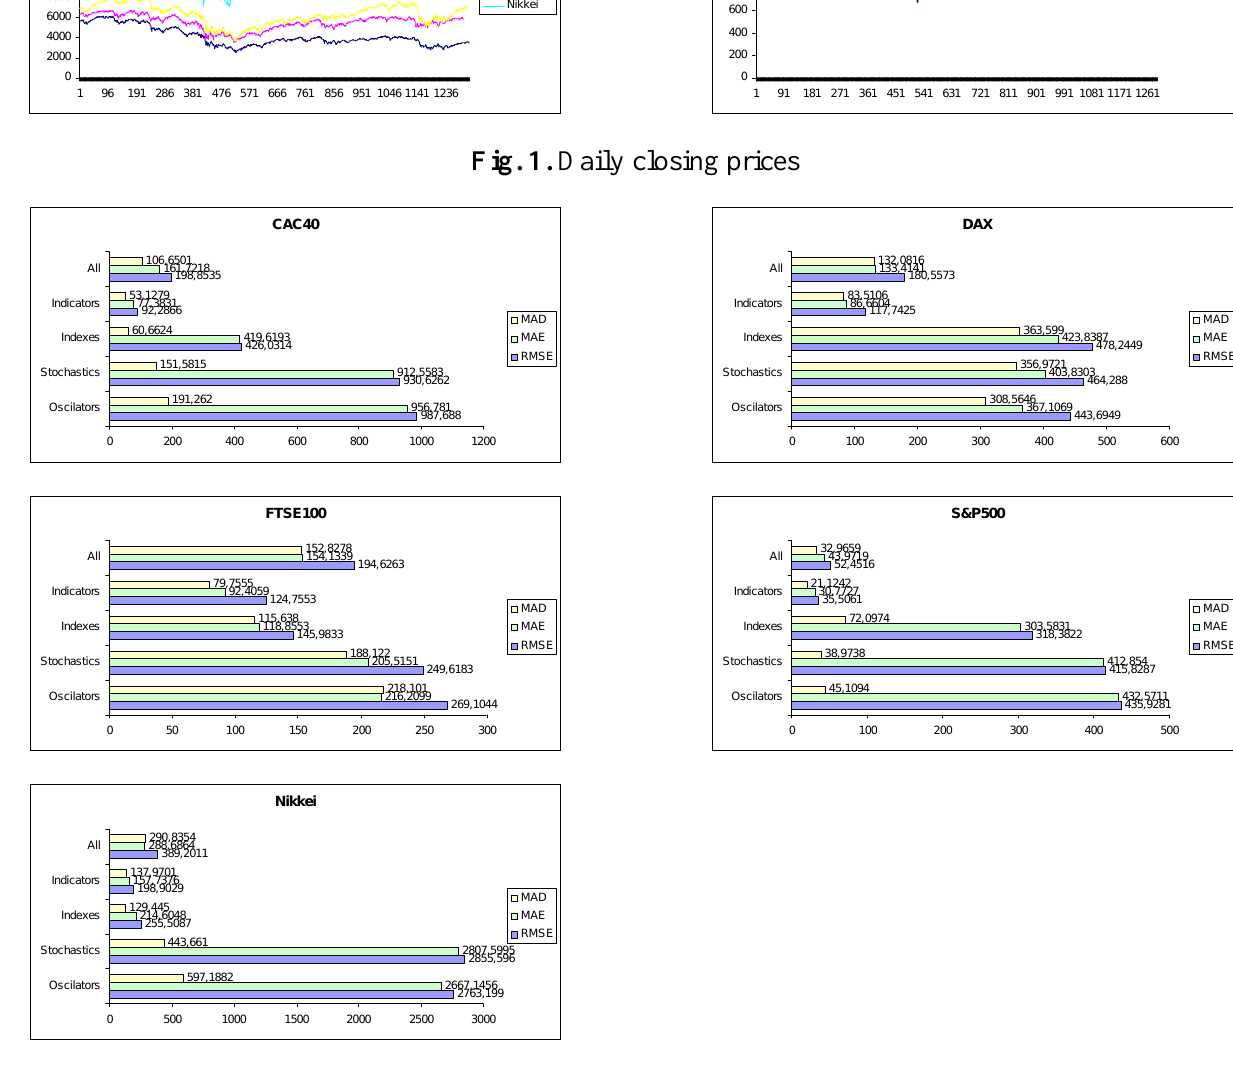
Fig. 2. Simulation